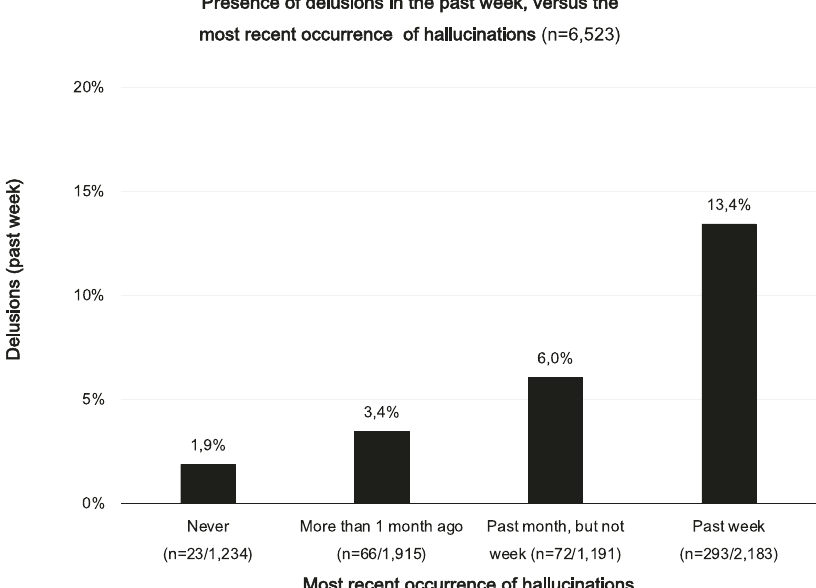
Fig. 6 Presence of delusions in the past week, plotted against the most recent occurrence of hallucinations. Total n = 6523. The distribution was statistically signi fi cant ( χ 2 228.3, p < .001, df 3). The presence of hallucinations was categorized as follows: Never, reported having never experienced hallucinations ( n delusions = 23); more than 1 month ago, reported having ever experienced hallucinations, but not during the past month ( n delusions = 66); past month but not week, reported having experienced hallucinations during the past month, but not the past week ( n delusions = 72); past week, reported having experienced hallucinations in the past week ( n delusions =